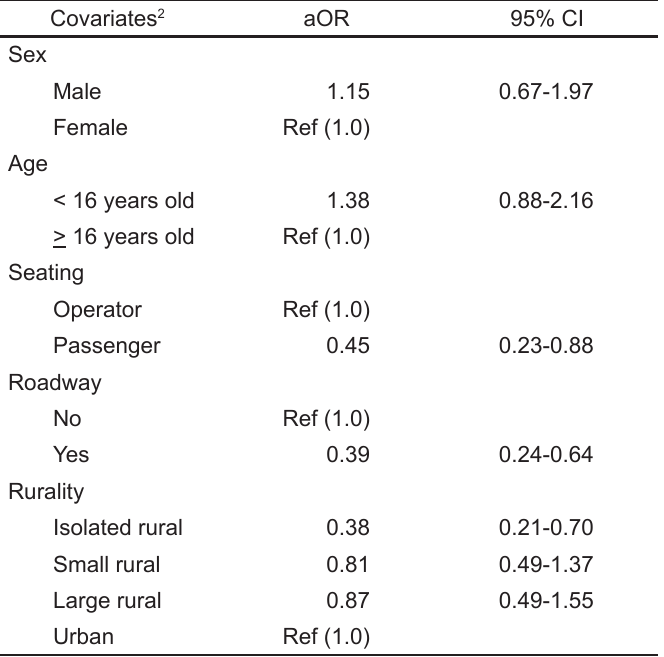
Table 3. Likelihood of crash victim being helmeted. 1 Multivariable regression analysis related to crash-victim helmet use in the Iowa Off-Road Vehicle Crash and Injury Database from January 1, 2002, through December 31, 2013.